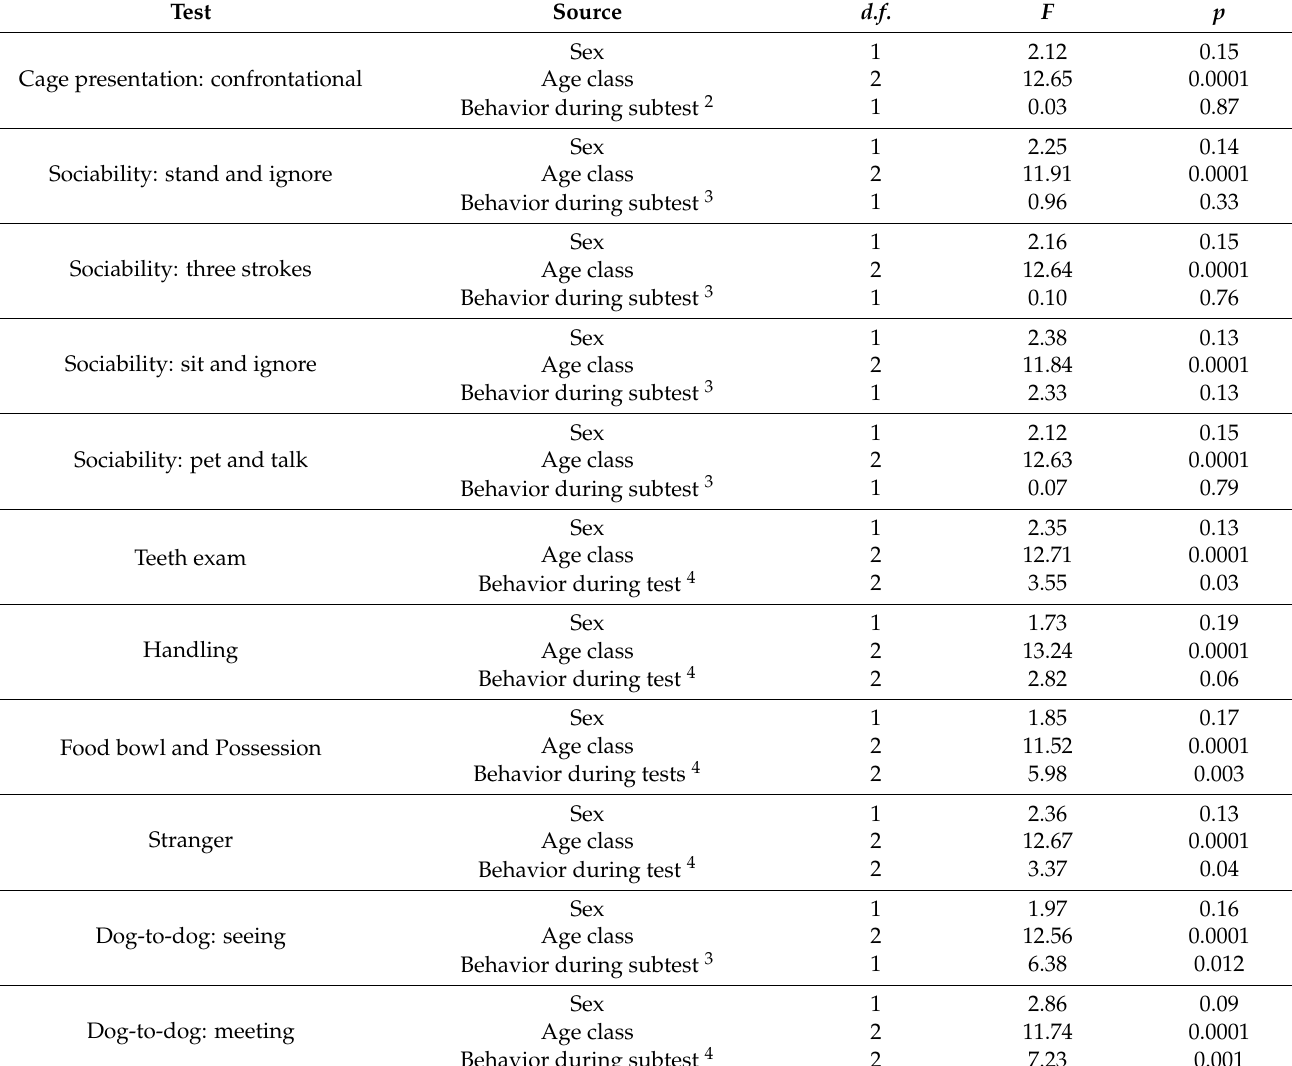
Table 6. Results of least squares models to determine predictors of length of stay of dogs at the shelter. Fixed factors are sex, age class, and behavior displayed during the specific test or subtest. Threshold for significance set at p ≤ 0.01 1 . Test